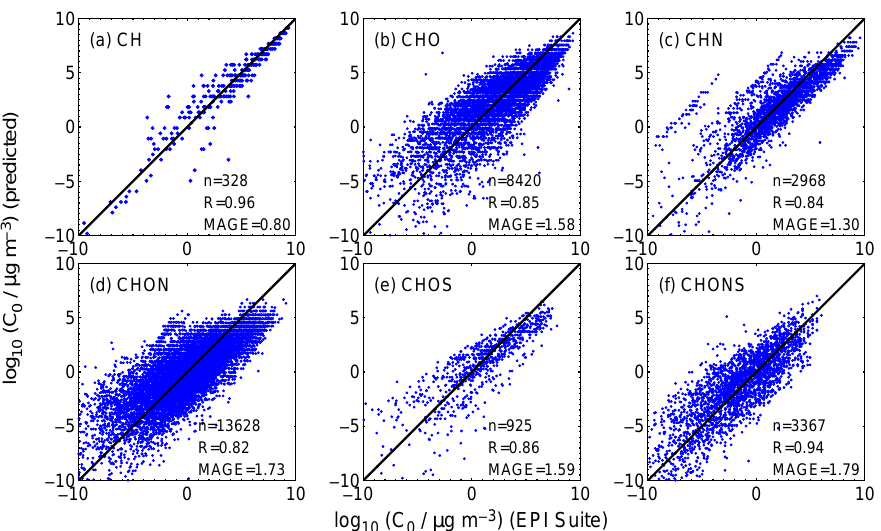
Figure 3. Saturation mass concentration ( C 0 ) of organic compounds predicted by Eq. (2) from this study plotted against C 0 determined by the EPI Suite software in the NCI database for elemental composition classes of (a) CH, (b) CHO, (c) CHN, (d) CHON, (e) CHOS, and (f) CHONS.